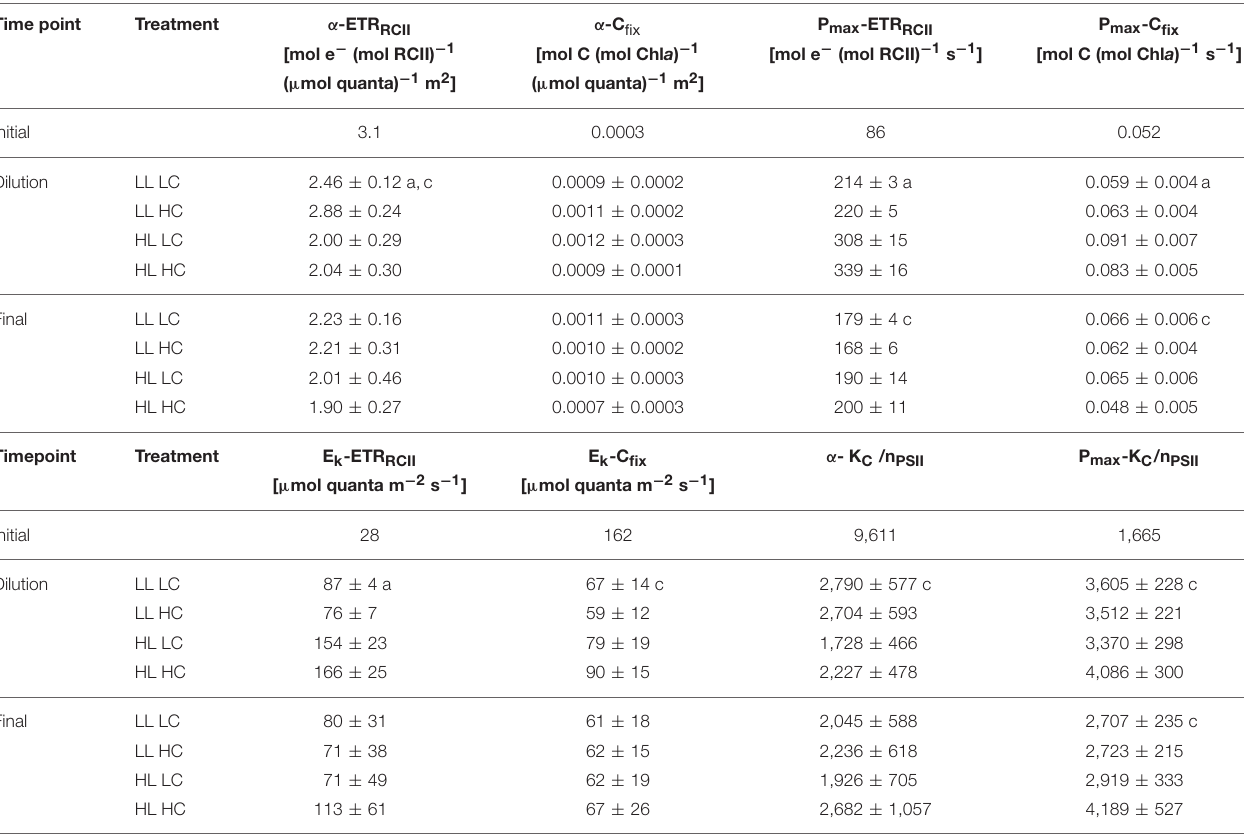
TABLE 3 | Photophysiological characteristics of phytoplankton assemblages directly before the dilution and at the end of the experiment ( n = 3; mean ± 1 s.d.). Time point Treatment α -ETR RCII α -C fix P max -ETR RCII P max -C